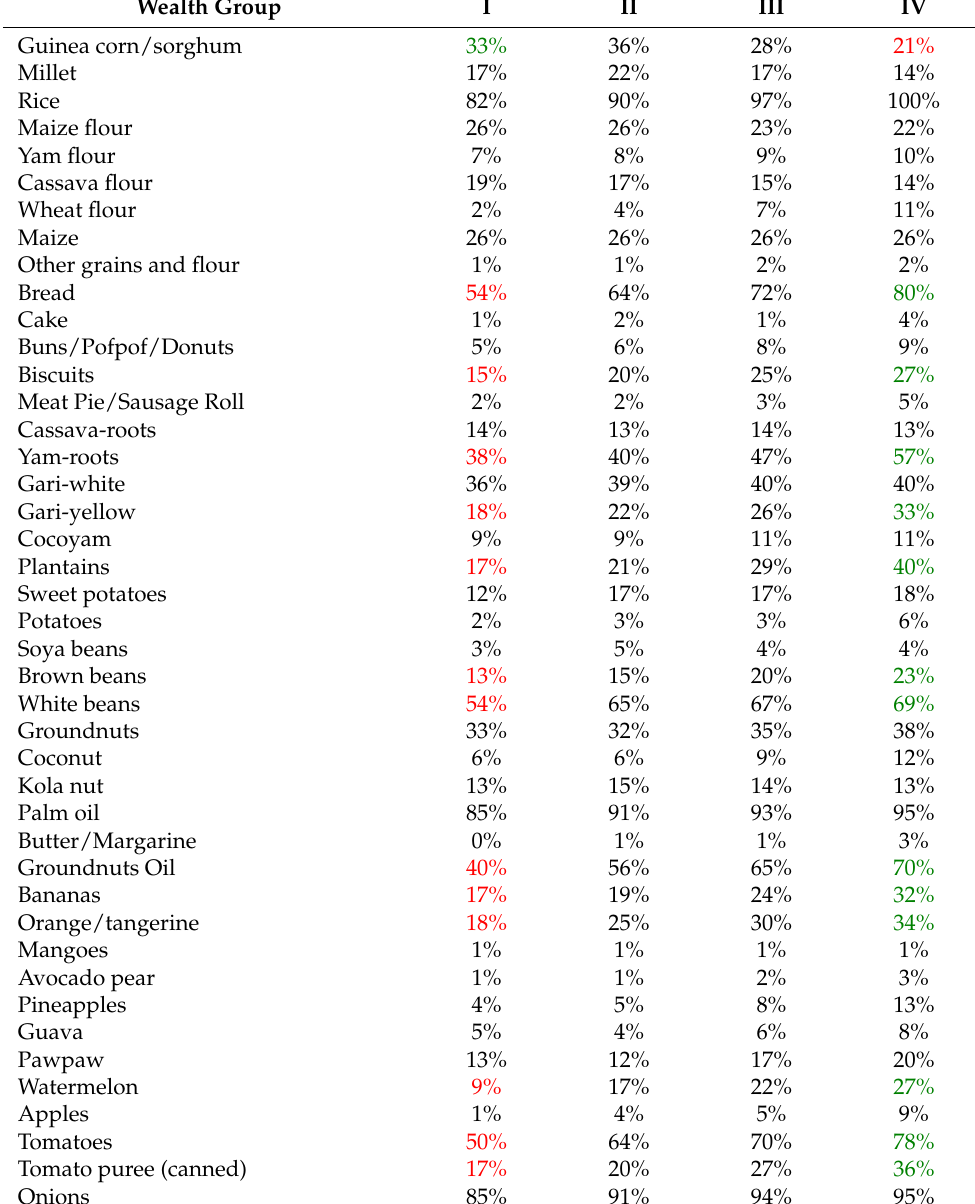
Table A7. Foods consumed in the 7 days prior to the survey by Nigerian households across different wealth groups